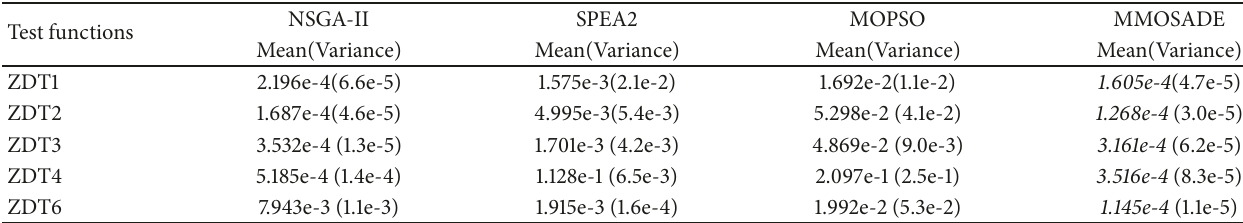
Figure 2: Flowchart of MMOSADE. Table 1: Test results of convergence.